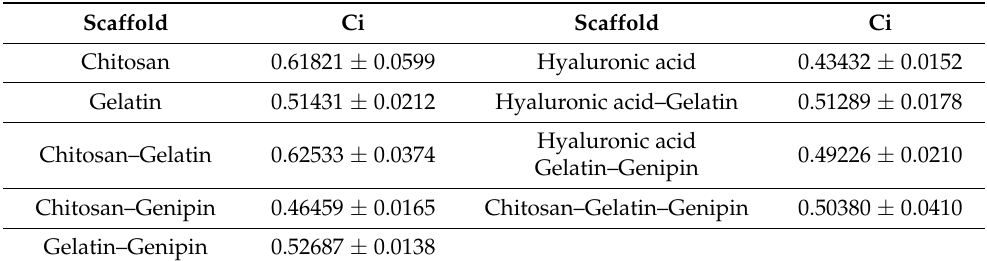
Figure 6. XRD of ( A ) hyaluronic acid, ( B ) gelatin, ( C ) HAGEL and ( D ) HAGELGEN. Table 1. Crystallinity index of each scaffold calculated from XRD (n =